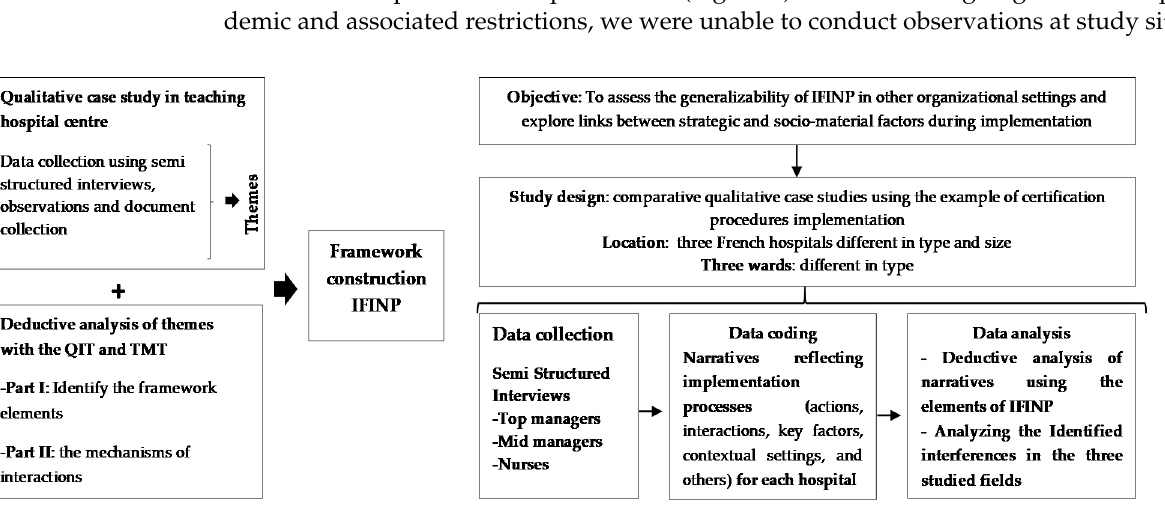
Figure 1. Flow diagram summarizing the used methodology to construct and assess the IFINP. Interviews